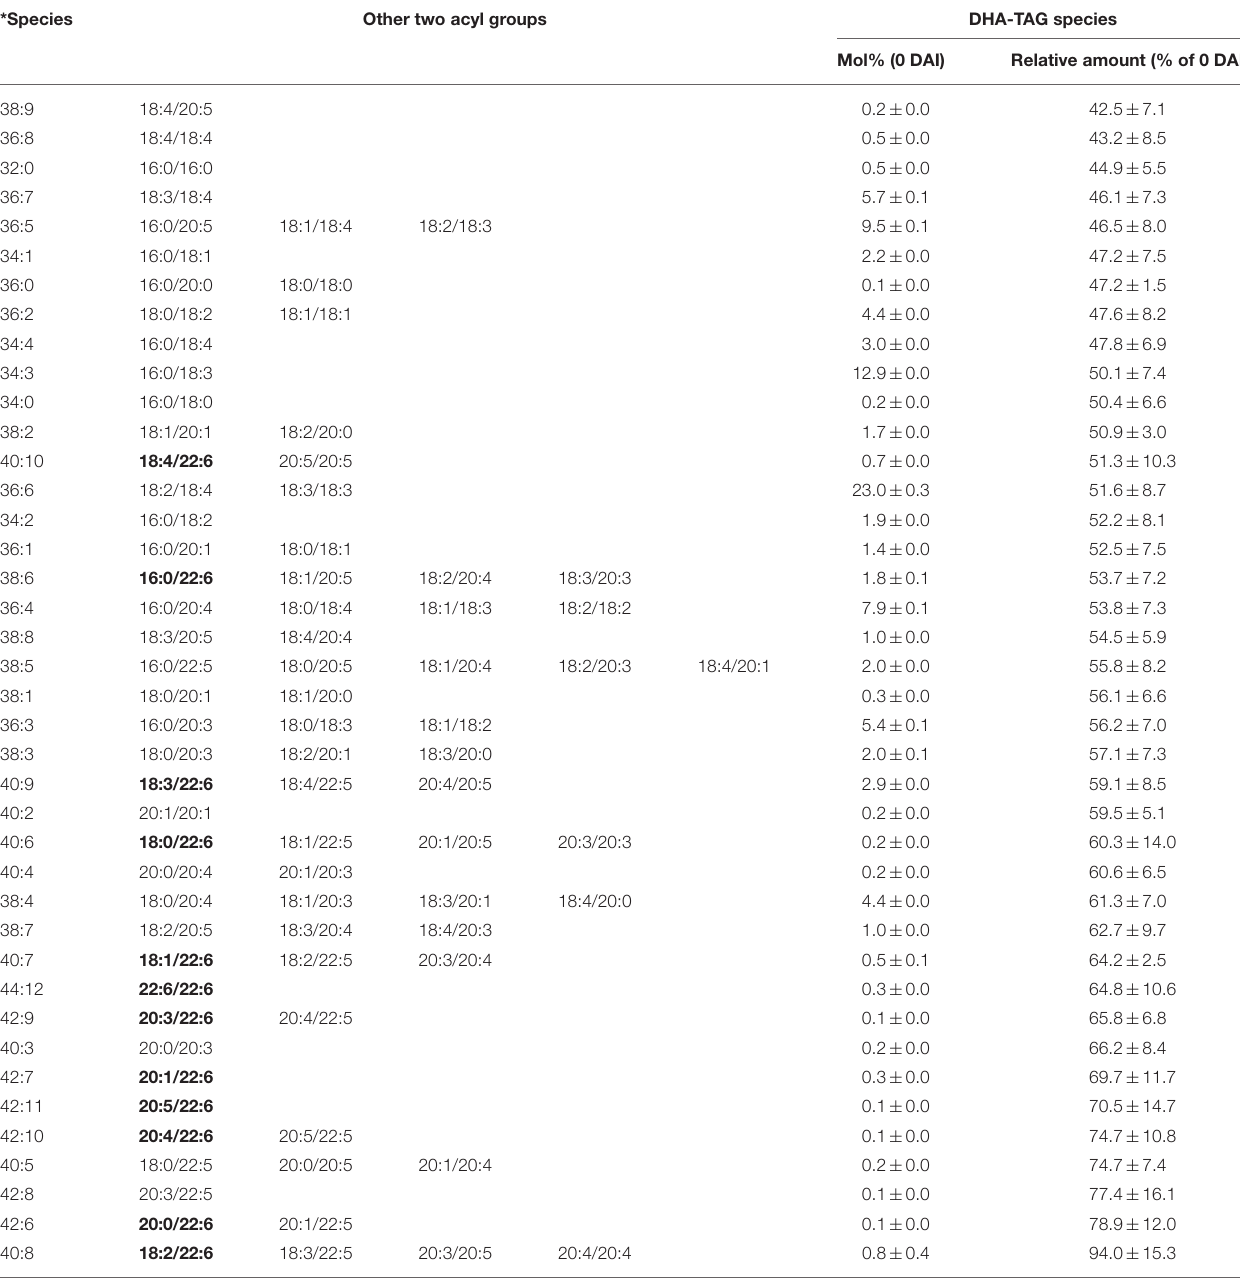
* Sum of carbon and double bond numbers in other two acyls of DHA-TAG. The list is in order of low to high amounts of remaining DHA-containing TAG species at 4 DAI compared to 0 DAI. Species containing minor FAs 14:0, 16:1, 22:1, (0.5%), 20:2 (0.6%), 22:3 (0.1%) were not shown. Potential combinations with at least one DHA (22:6) in other two acyls are shown in